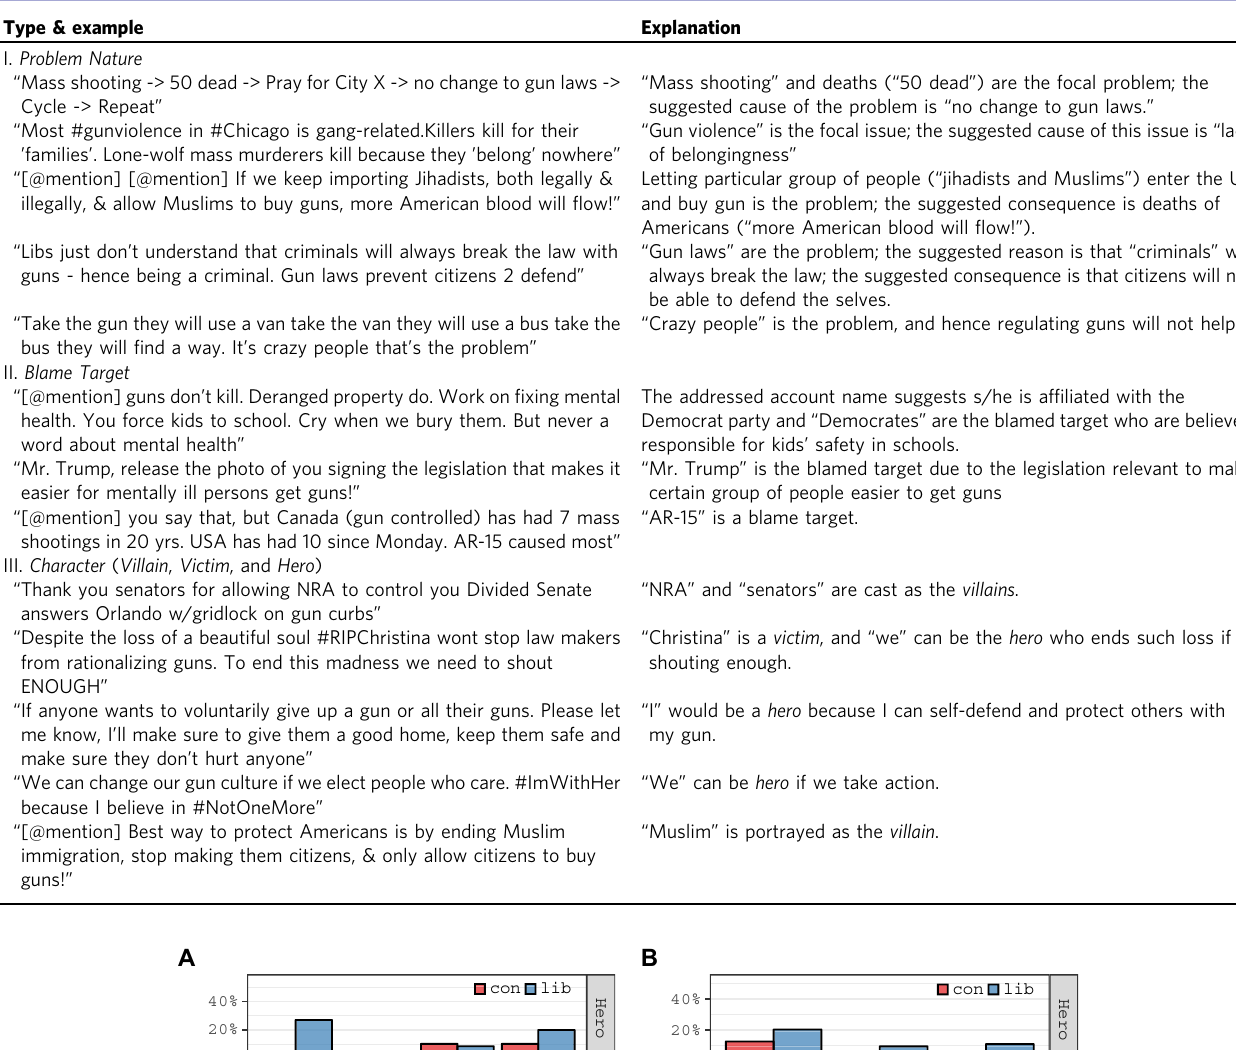
Table 3 Attributional Elements identi fi ed from a causal-attributional narrative.